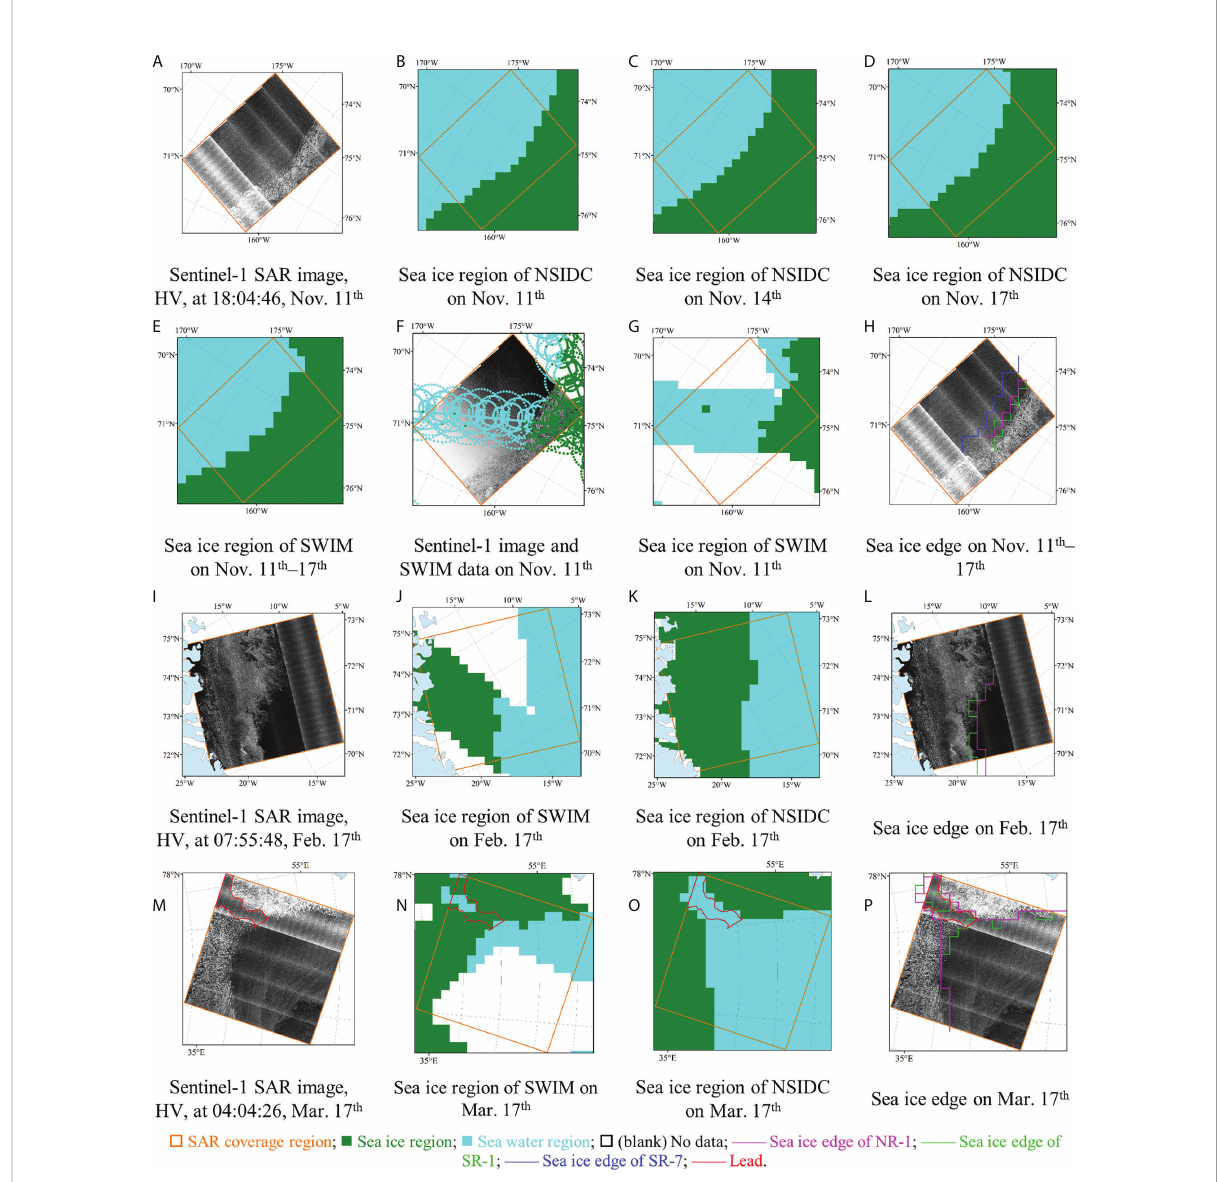
FIGURE 9 Sea ice edges based on SWIM and NSIDC data with synchronous Sentinel-1 SAR images. (A) Sentinel-1 SAR image, HV, at 18:04:46, Nov. 11 th ; (B) Sea ice region of NSIDC on Nov. 11 th ; (C) Sea ice region of NSIDC on Nov. 14 th ; (D) Sea ice region of NSIDC on Nov. 17 th ; (E) Sea ice region of SWIM on Nov. 11 th – 17 th ; (F) Sentinel-1 image and SWIM data on Nov. 11 th ; (G) Sea ice region of SWIM on Nov. 11 th ; (H) Sea ice edge on Nov. 11 th – 17 th ; (I) Sentinel-1 SAR image, HV, at 07:55:48, Feb. 17 th ; (J) Sea ice region of SWIM on Feb. 17 th ; (K) Sea ice region of NSIDC on Feb. 17 th ; (L) Sea ice edge on Feb. 17 th ; (M) Sentinel-1 SAR image, HV, at 04:04:26, Mar. 17 th ; (N) Sea ice region of SWIM on Mar. 17 th ; (O) Sea ice region of NSIDC on Mar. 17 th ; (P) Sea ice edge on Mar. 17 th